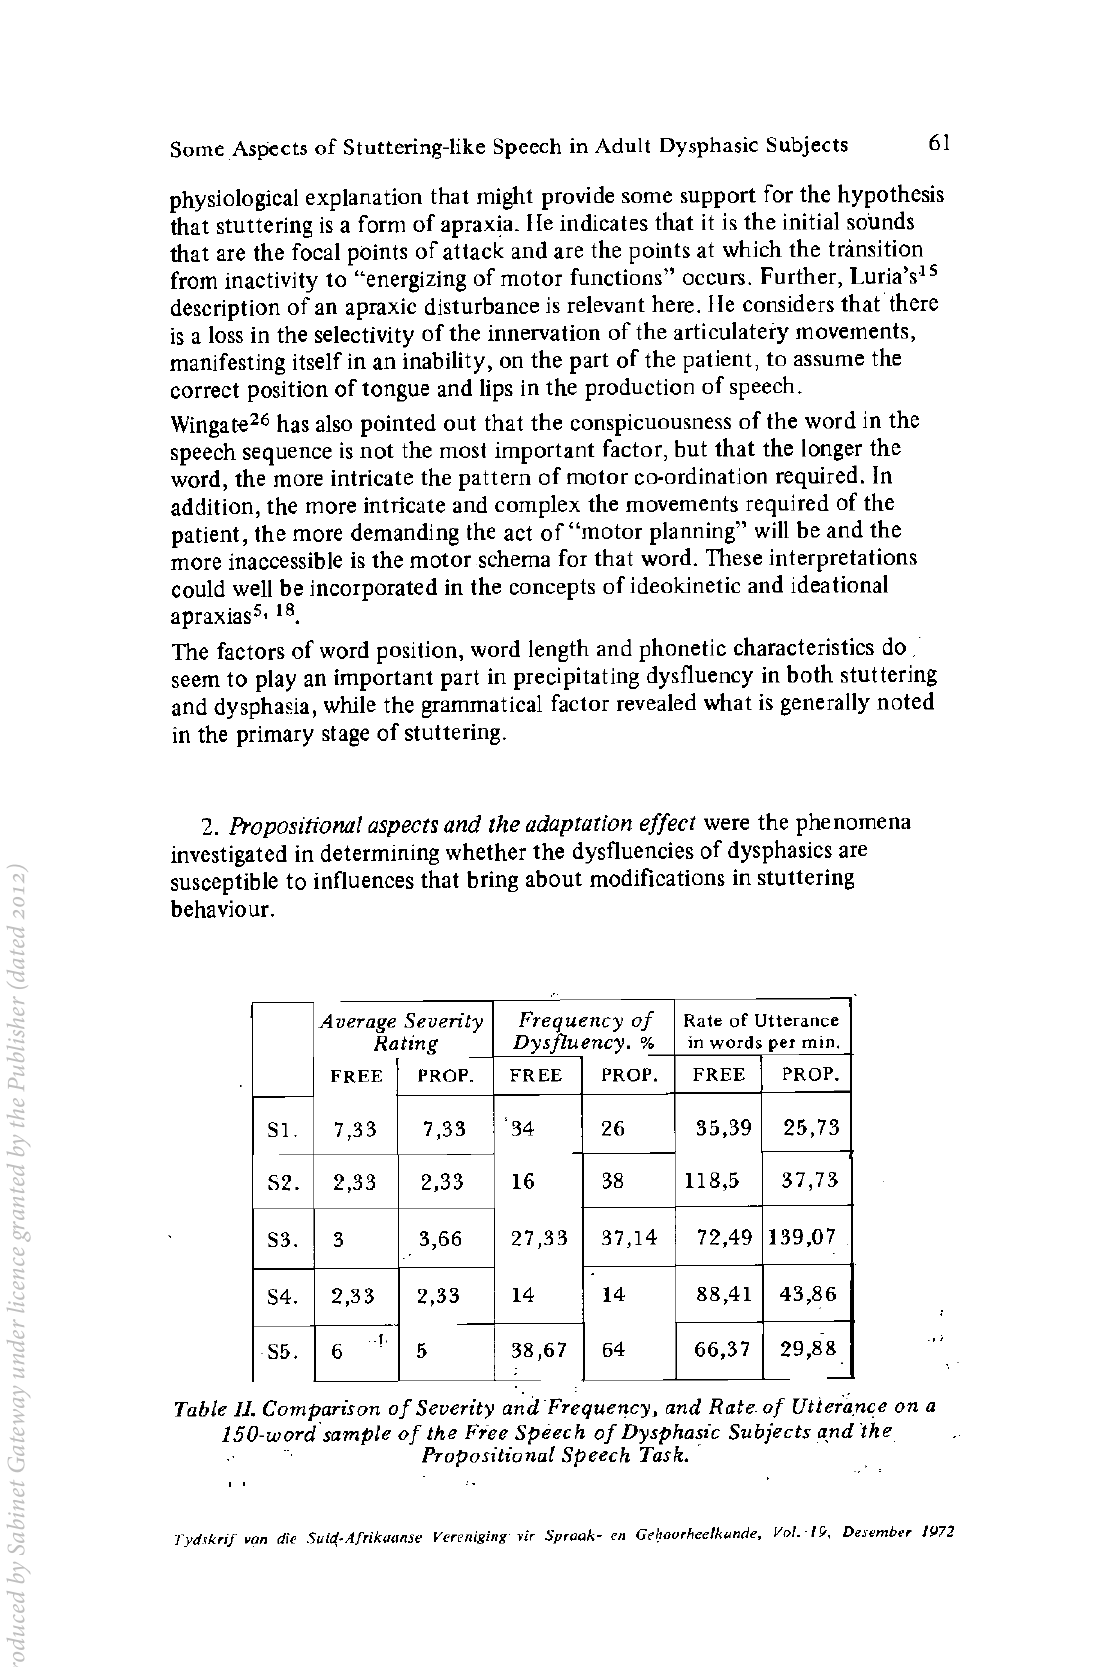
Table II. Comparison of Severity and Frequency, and Rate of Utterance on a 150-word sample of the Free Speech of Dysphasic Subjects and the Propositional Speech Task.